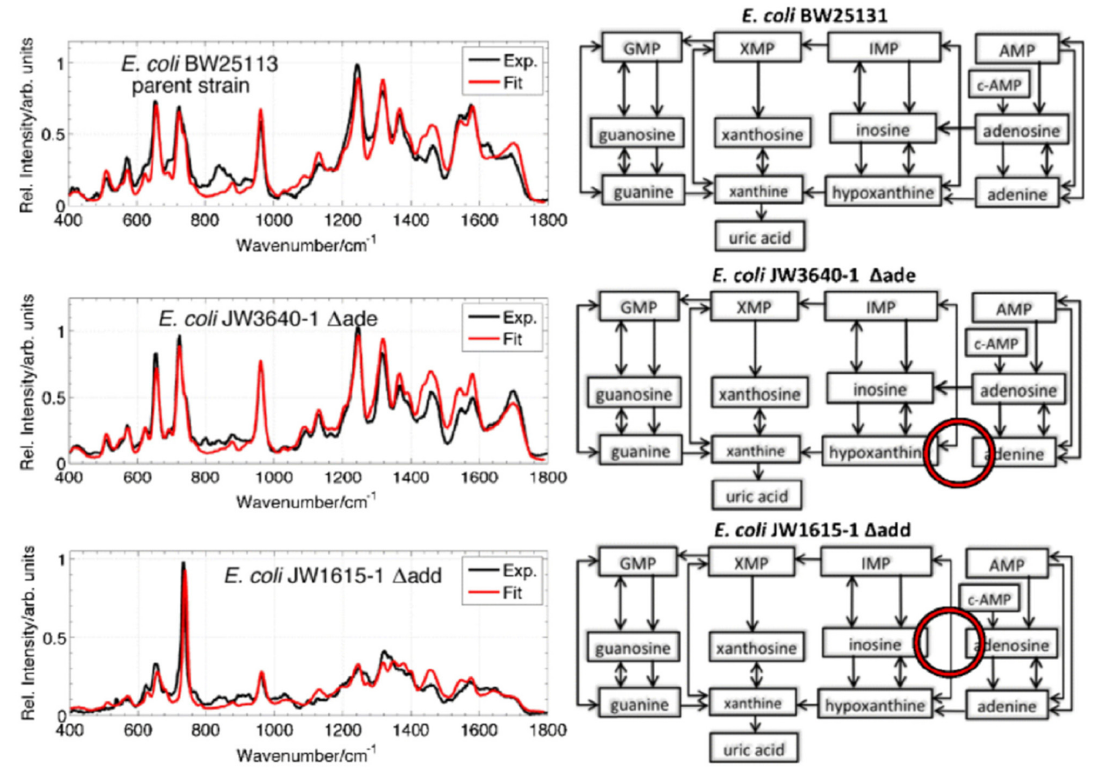
Figure 8. SERS spectra of parent strains and two mutants of Escherichia coli, and the corresponding purine metabolic pathway. Reproduced with permission of Ref. [56] , Copyright 2015, John Wiley & purine metabolic pathway. Reproduced with permission of Ref. [56], Copyright 2015, John Wi- Sons. ley &